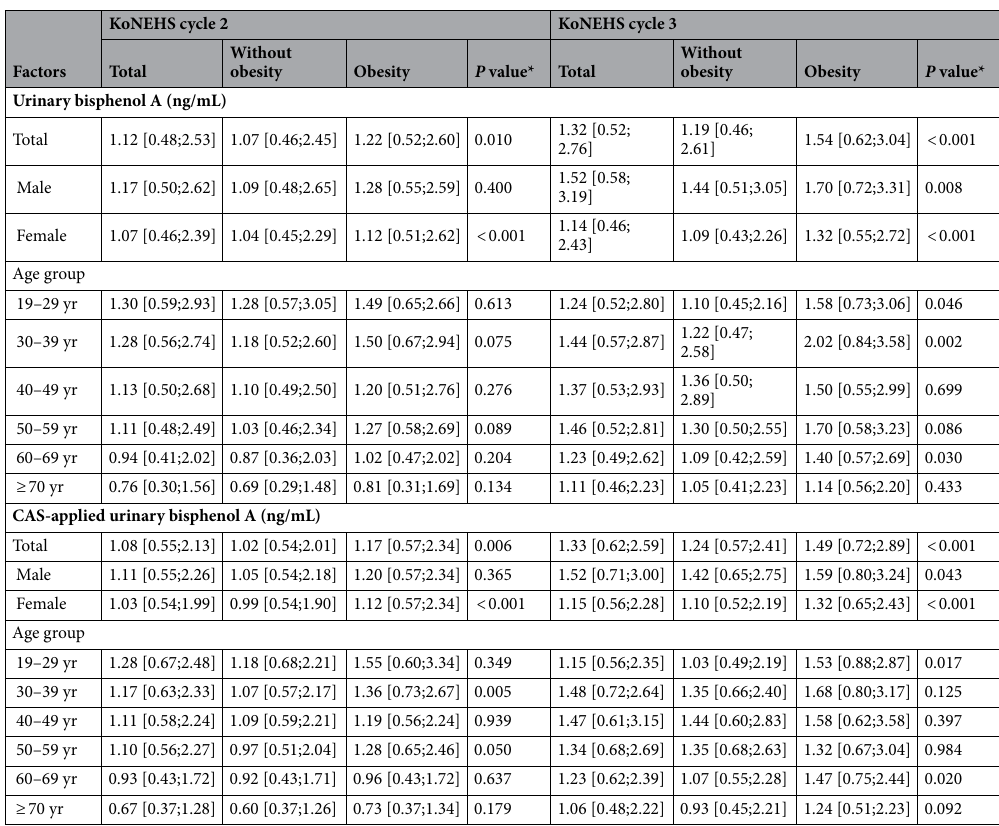
Table 2. Urinary bisphenol A and CAS-applied urinary bisphenol A according to the participants’ general characteristics and obesity. *General linear model of log-transformed BPA or log-transformed BPA CAS-BPA after adjusting for age and sex. CAS-BPA, CAS-applied urinary BPA. Data are presented as median values [interquartile range].